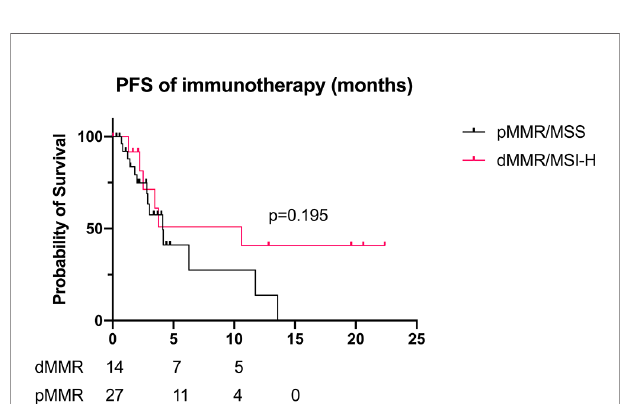
FIGURE 5 | PFSofimmunotherapy for recurrent/advanced GC patients (dMMR/MSI-H: n = 14; pMMR: n = 27; mPFS10.6 vs . 4.1 months, p = 0.195). PFS, progression-free survival; GC, gastriccancer;dMMR, de fi cient DNA mismatch repair; MSI-H, microsatellite instability-high; pMMR, pro fi cient mismatch repair; mPFS, median